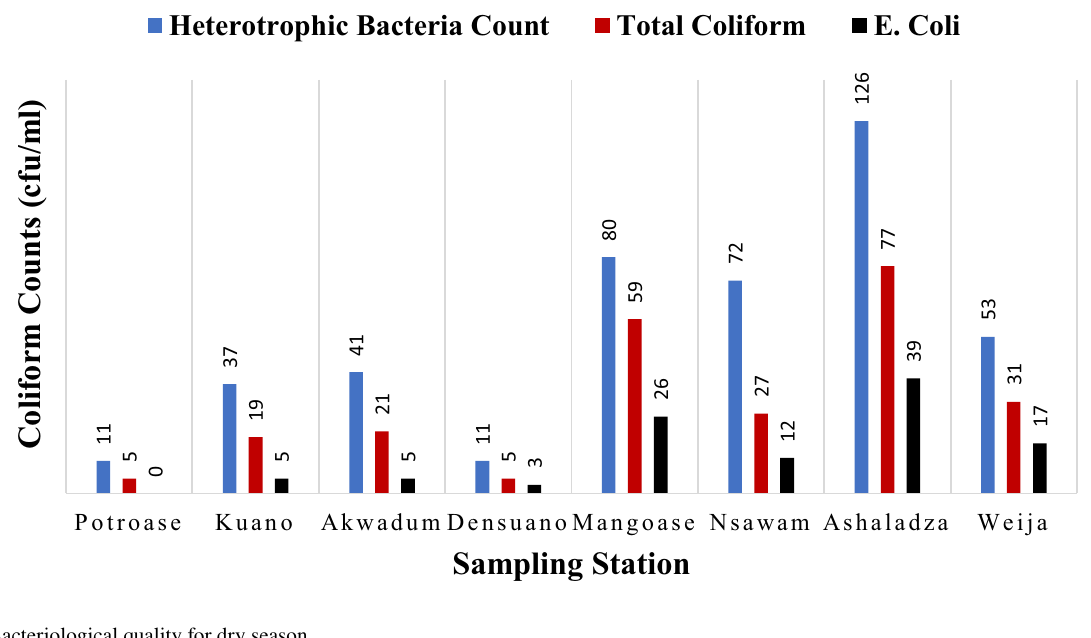
Fig. 6 Bacteriological quality for dry season